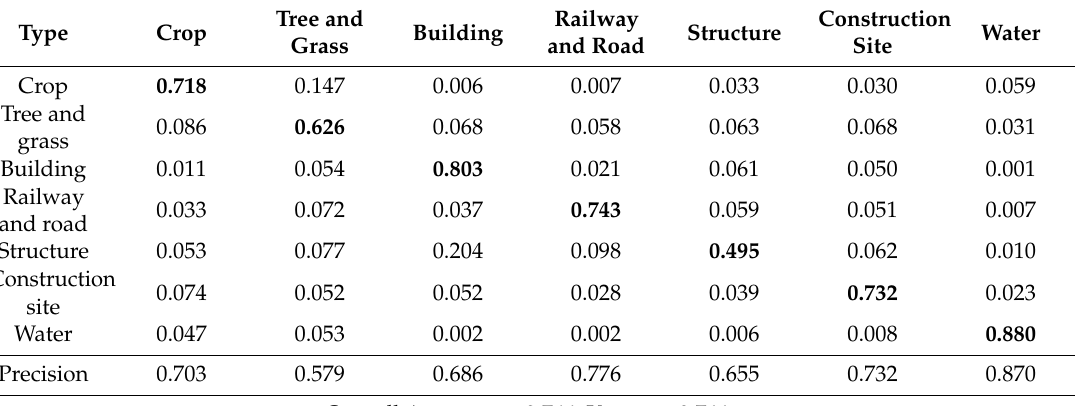
Table 2. The confusion matrix of our method on the patch samples. Table 3. The confusion matrix, OA and Kappa of our method on the test